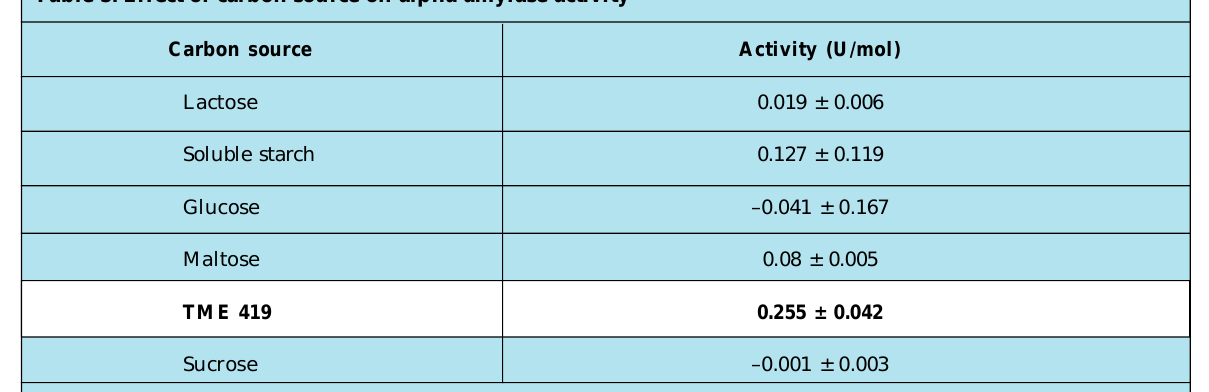
Table 5: Effect of carbon source on alpha amylase